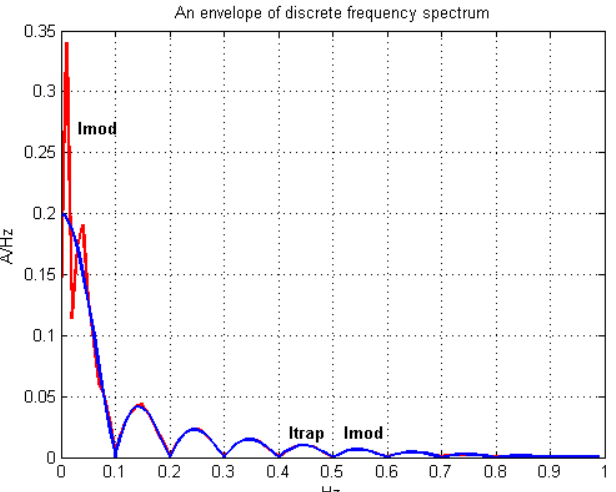
Figure 9. Spectrum envelope of trapezoidal pulse I trap and its modification in second step I mod .